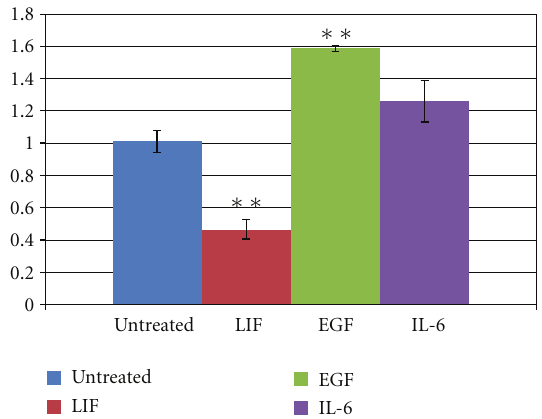
Figure 3: CaSki cells grown for 40 hours in the presence of the indicated agents were assayed by MTT for proliferation/metabolic activity. EGF and IL-6 enhanced cell number, while LIF inhibited proliferation. Error bars represent standard error of the mean. Asterisks represent significance ( ∗∗ P < .